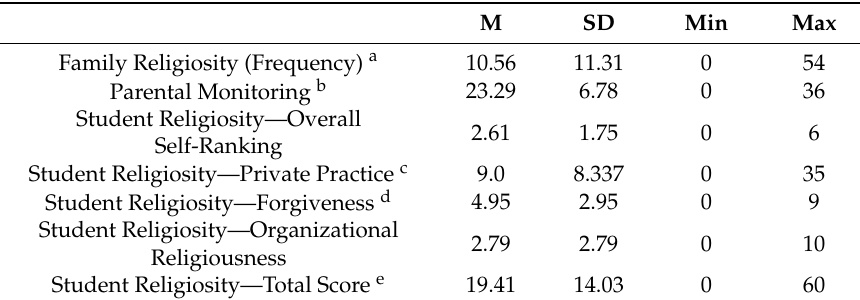
Table 2. Summary score statistics ( n =